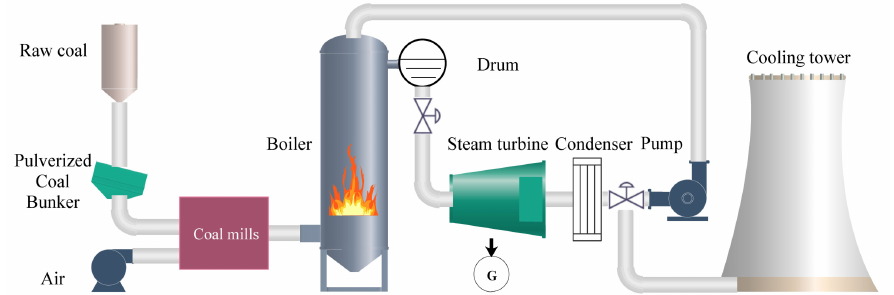
Figure 1. Simplified schematic diagram of a thermal power unit including main